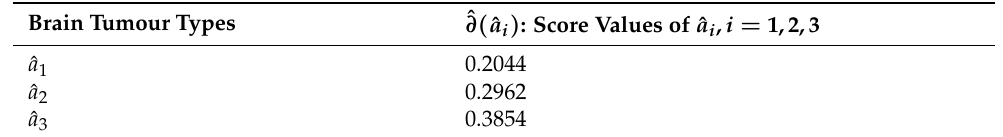
Table 15. Scores of alternatives ˆ a i , i = 1,2,3 corresponding to ˆ ℘ j , j = 1,2,3,4 computed through harmonic mean.